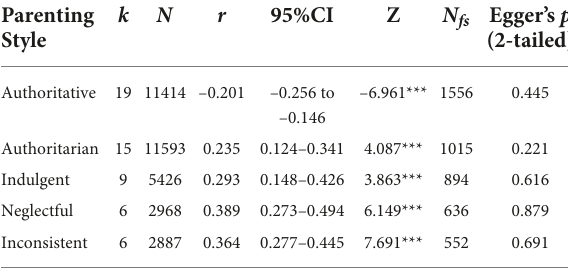
TABLE 3 Overall effect size results and publication bias